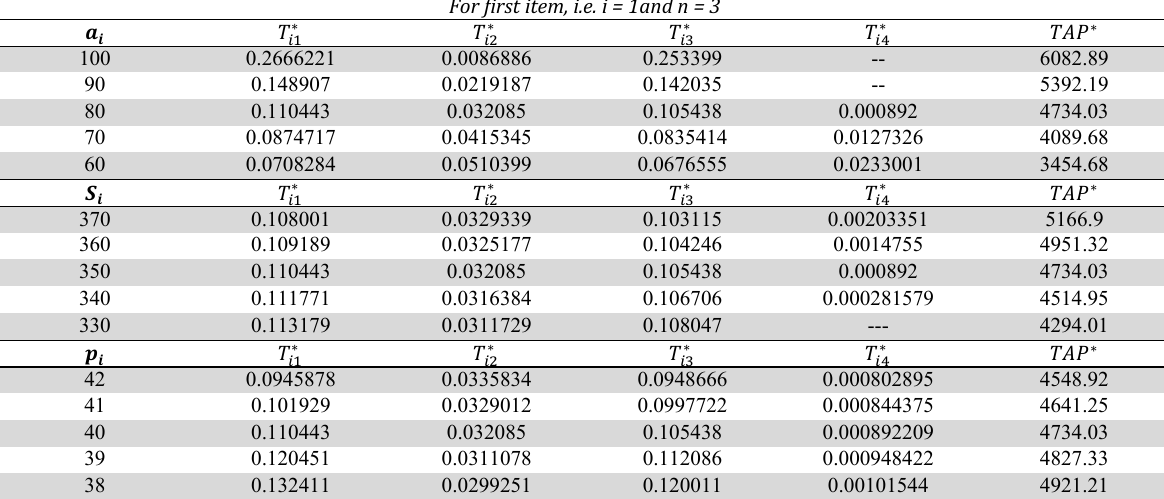
Effect of changes in the parameters of the inventory